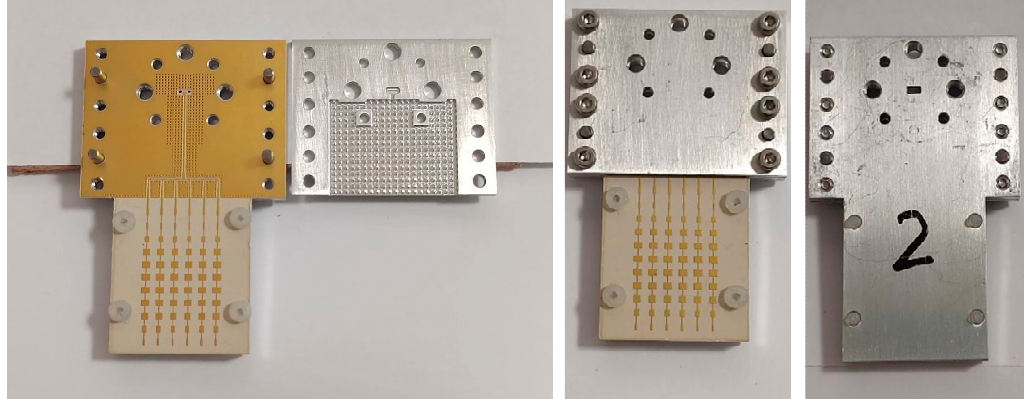
Figure 15. A fabricated prototype of the proposed low-SLL planar array.